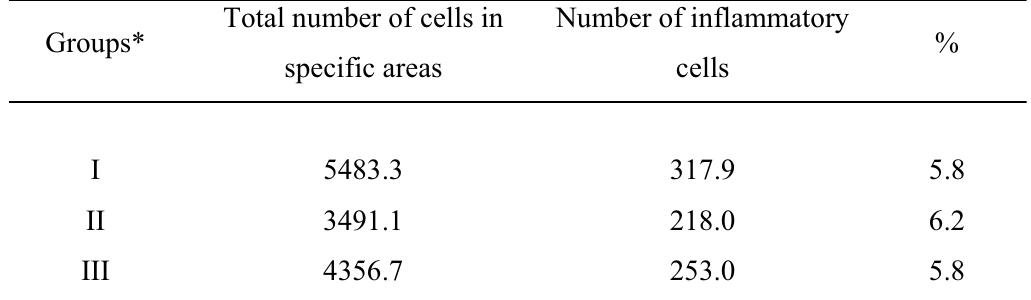
TABLE 2 - Number of inflammatory cells and the percentage of such cells related to the total number of cells in a specific